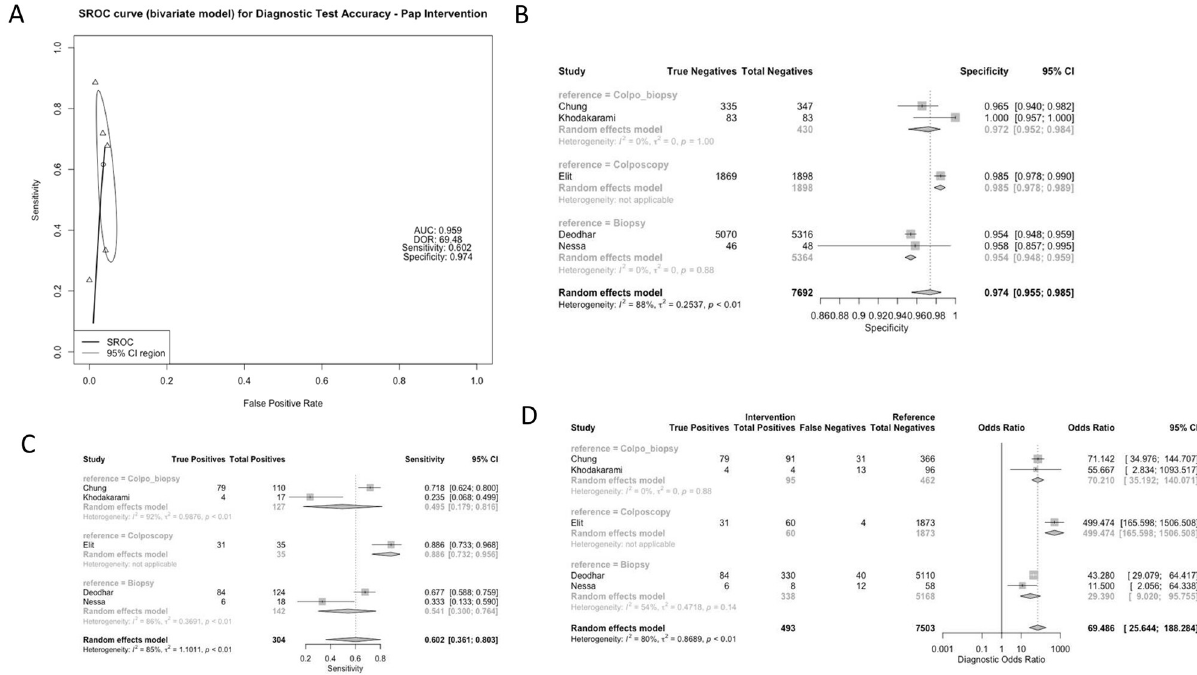
Fig 5. Panel A: Pooled Receiver Operating Characteristic for Diagnostic Test Accuracy for Pap smear intervention. Panel B: Specificity of Studies for Pap smear intervention. Panel C: Sensitivity of Studies for Pap smear intervention. Panel D: Diagnostic Odds Ratio for Pap smear intervention.